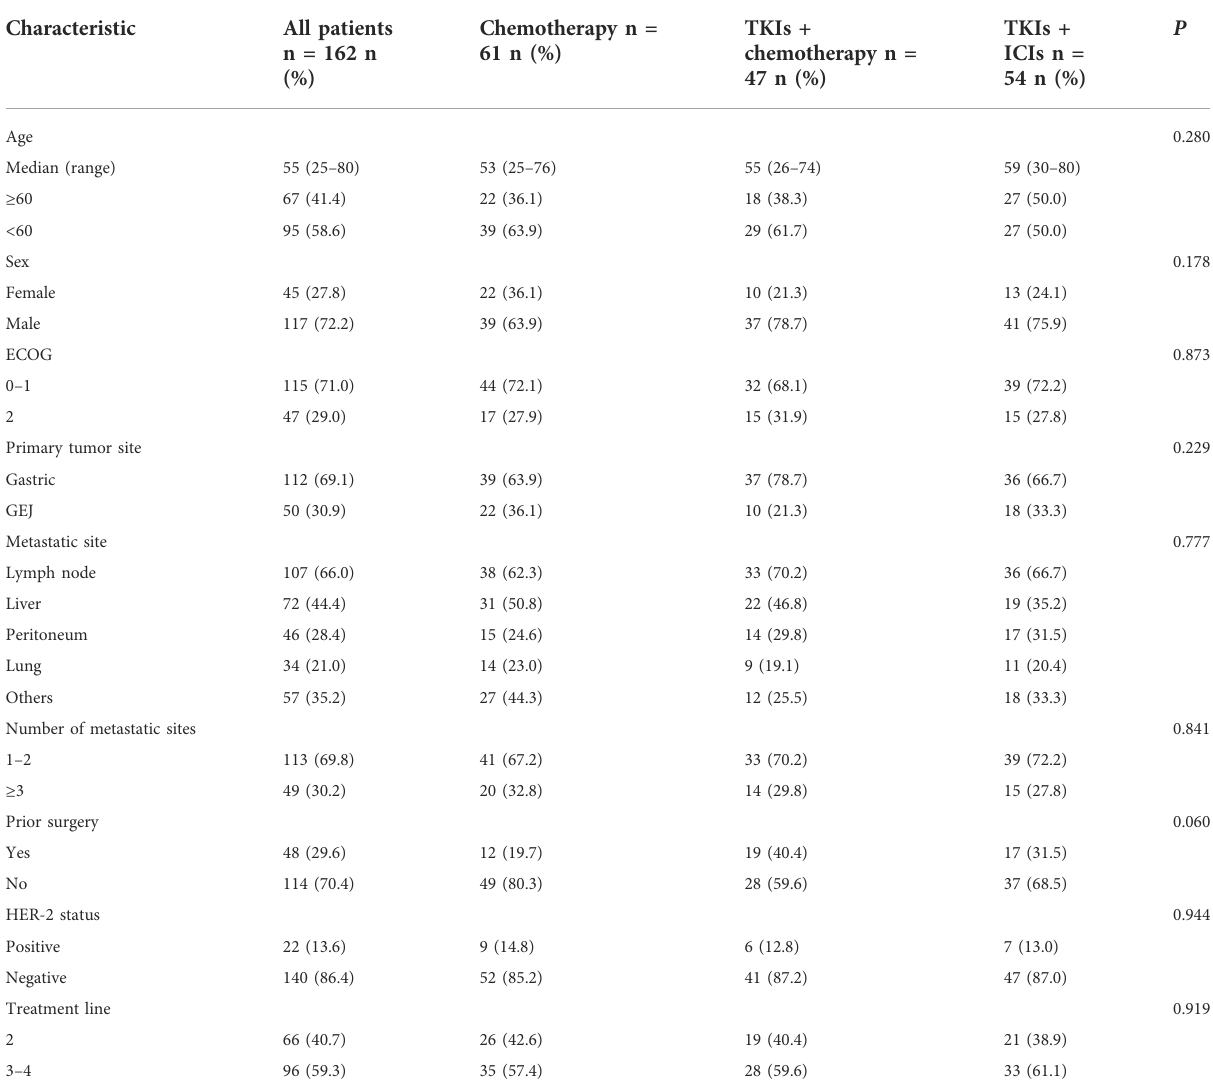
TABLE 1 Patient and treatment